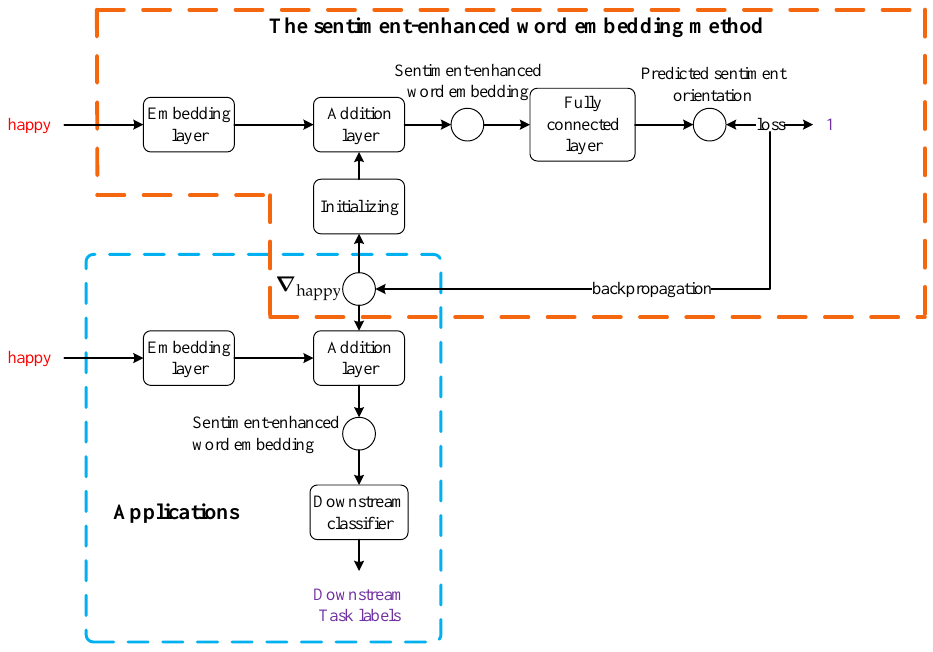
Figure 2. The workflow of S-EWE method and its applications on the downstream tasks. The orange dashed box indicates the stage in which we train the S-EWE embeddings, and the blue dashed box represents the stage in which we apply the embeddings to downstream tasks. The red texts are the inputs, and the purple texts are the